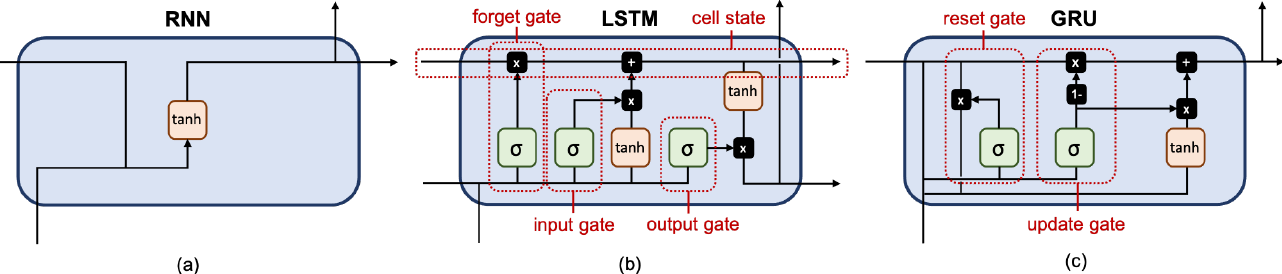
Figure 3. Schematic diagram of each recurrent unit with different stored states: ( a ) FRNN with a hidden state, whose activation at each time depends on that of the previous time; ( b ) LSTM has a cell state and multiple control gates to modulate the flow of information so that each recurrent unit can adaptively perceive dependencies on different time scales; ( c ) GRU simplifies the input gate and forget gate of LSTM into an update